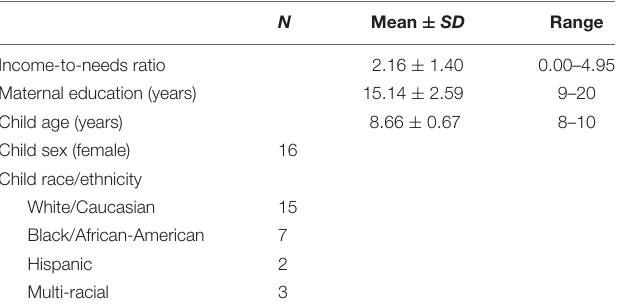
TABLE 1 | Income-to-needs ratio, maternal education, and demographic information for the sample. N Mean ± SD